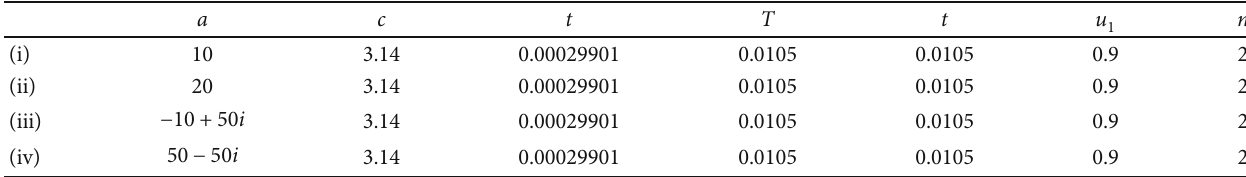
Table 3: Parameters for generation of quadratic Julia set for di ff erent values of a